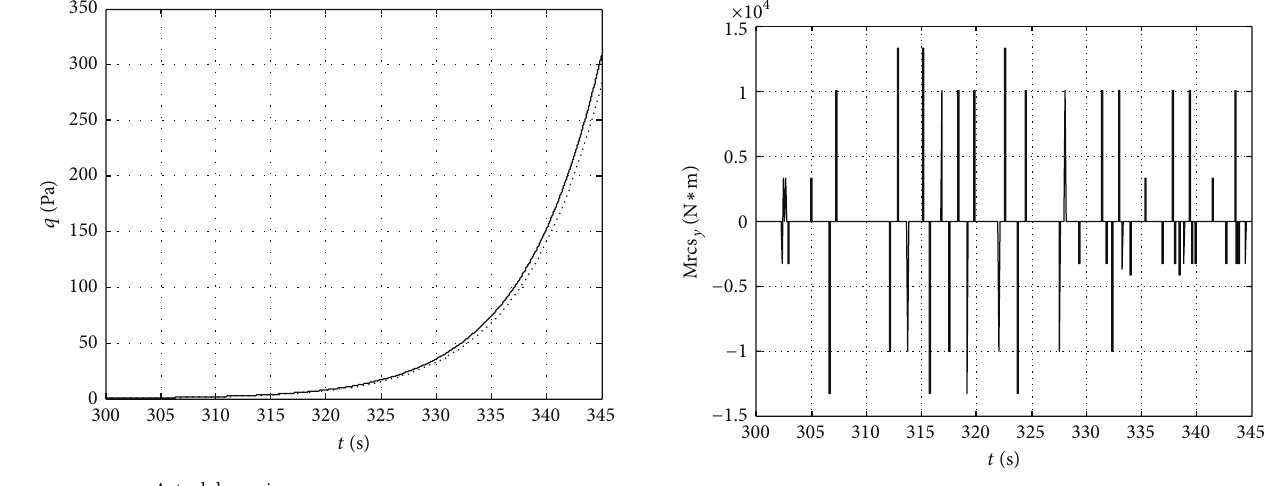
Figure 22: Simulation result of RCS yaw moment.